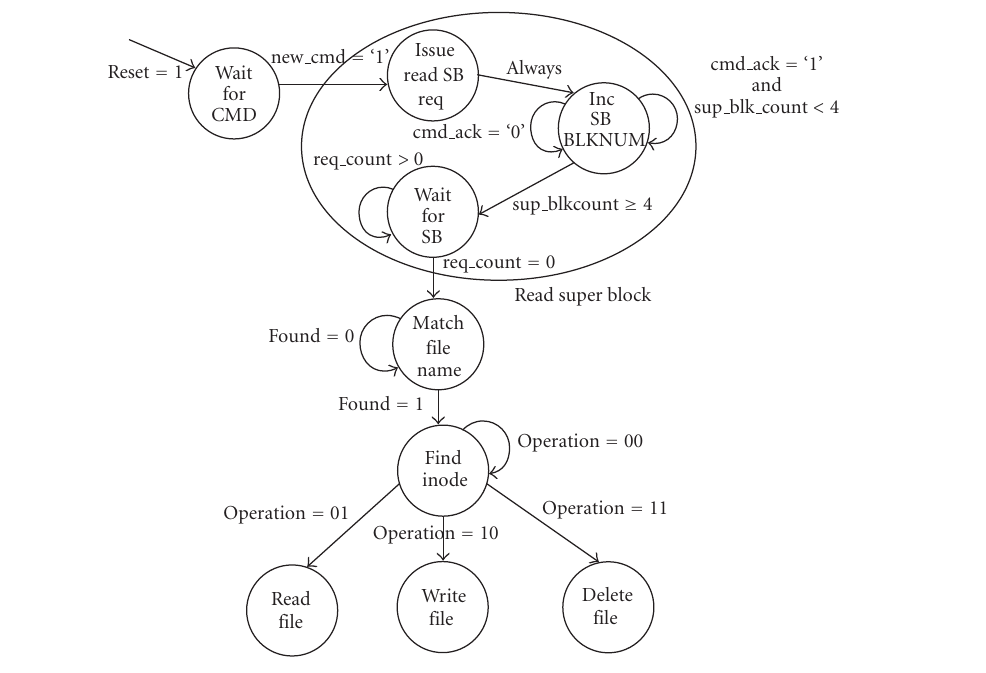
Figure 6: Open file state